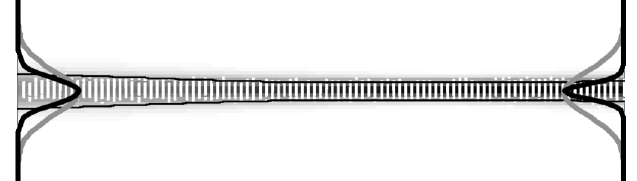
FIG. 3. Profile of the optical mode (gray shading) and electron beam (vertical white lines at each calculation step) along the undulator for z 0 ¼ 0 : 05 in the small signal regime. The gray optical mode profile uses z 0 from Eq. (2) and the simple theory; the black profile is the actual mode profile from the simulation.